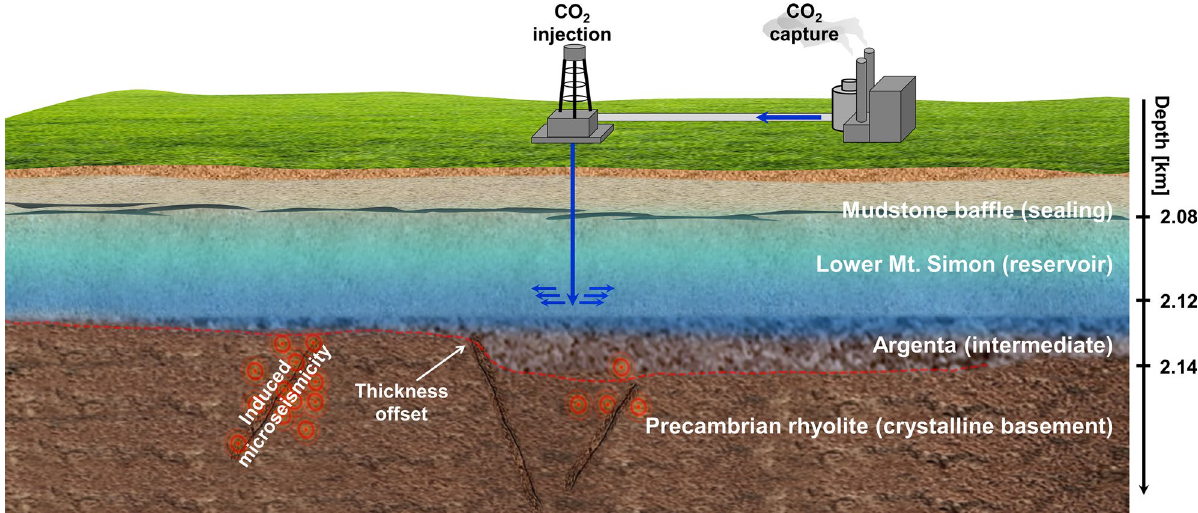
Figure 1. Sketch of stratigraphy involved in CO 2 injection into the deep saline aquifer in Illinois Basin. Low- permeable mudstone baffles restrict the vertical flow of CO 2 to the upper part of the reservoir. The thickness of the intermediate layer (Argenta) abruptly thins over topographic high in the crystalline basement (Precambrian rhyolite). Observed induced microseismicity is likely to be associated with the reactivation of the critically stressed basement